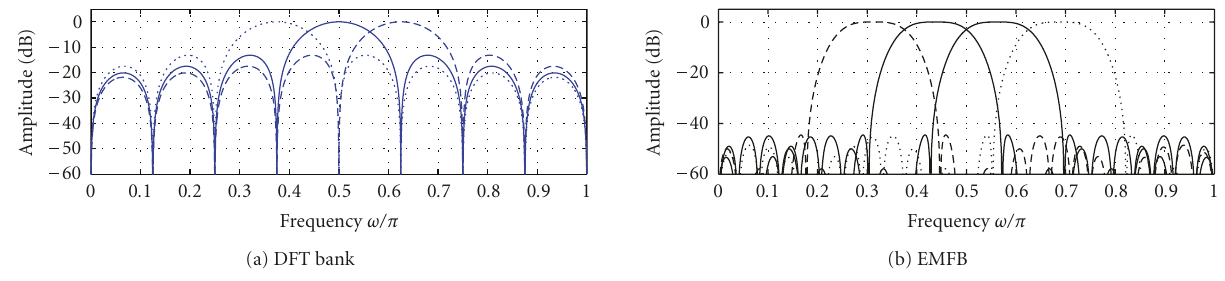
Figure 3: Comparison of the subband frequency responses of DFT and EMFB.